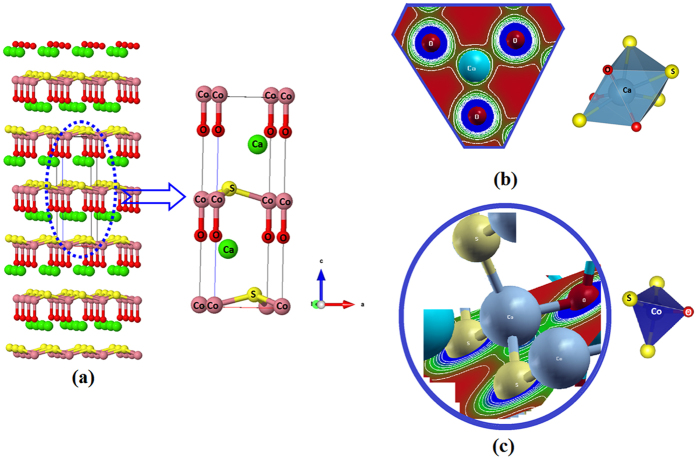
Crystal structure of the antiferromagnetic CaCoSO Single Crystal.(b) electron cloud in CaS4O3 (c) electron cloud in CoS3O tetrahedron Co-O strong covalent bond.